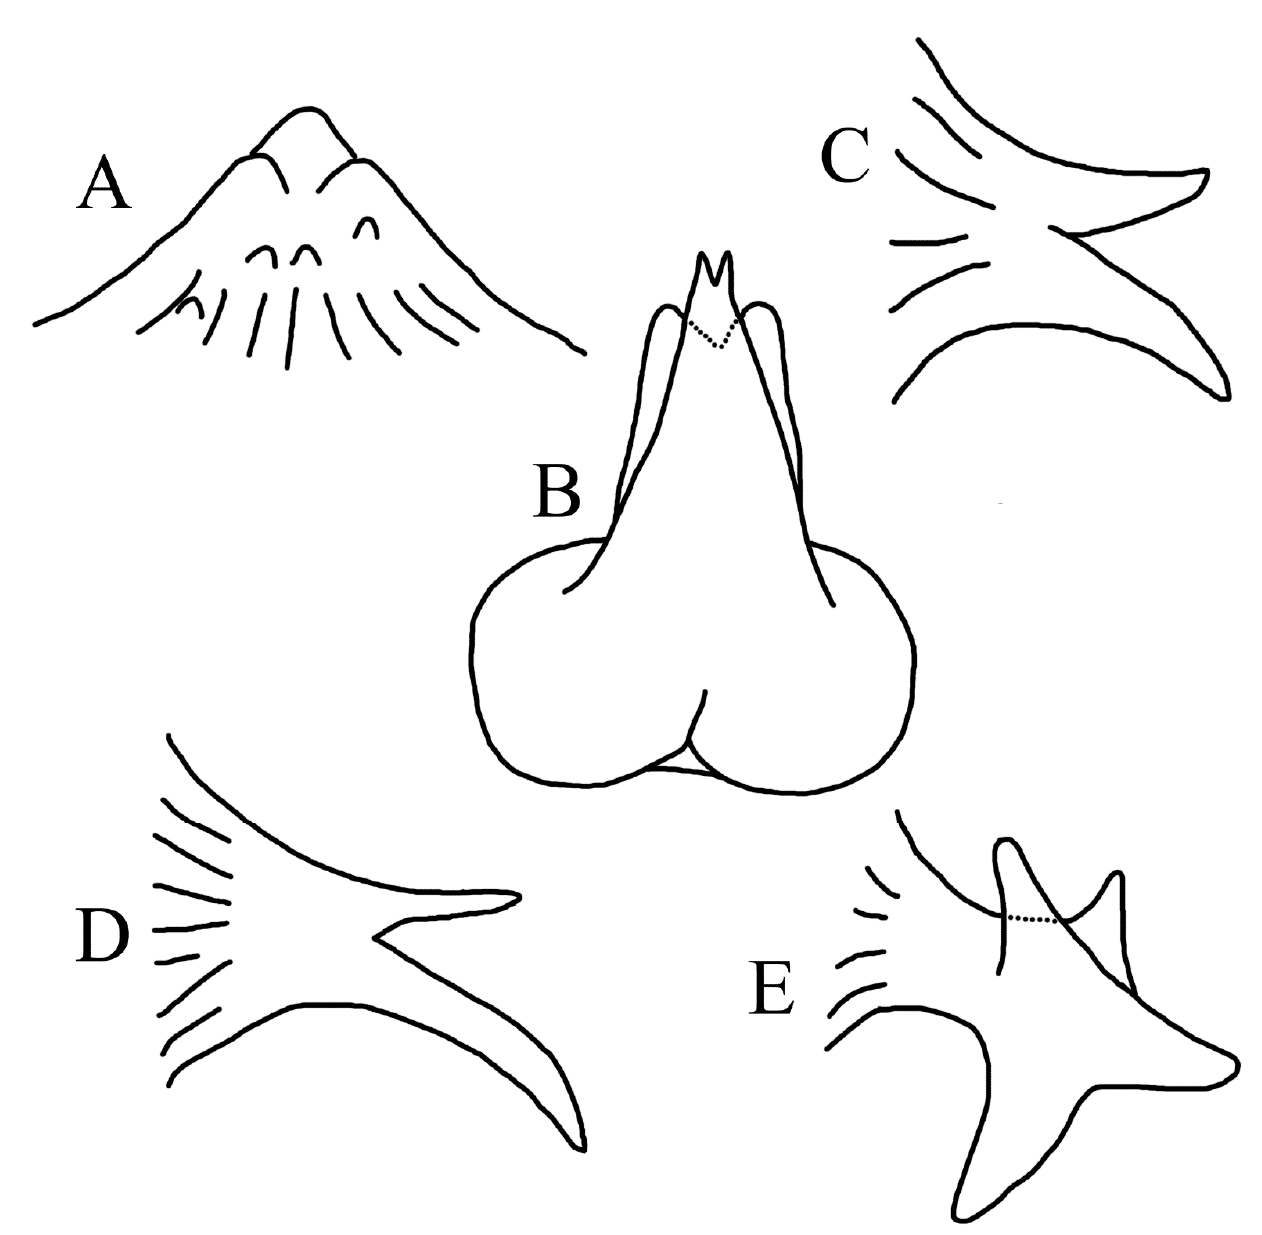
Figure 30. Esca and squamation of H. okamurai sp. nov., from holotype. ( A ). Rostral tubercles. ( B ). Esca. ( C ). Tubercle on disk margin. ( D ). Tubercle on tail. ( E ). Subopercular tubercle.